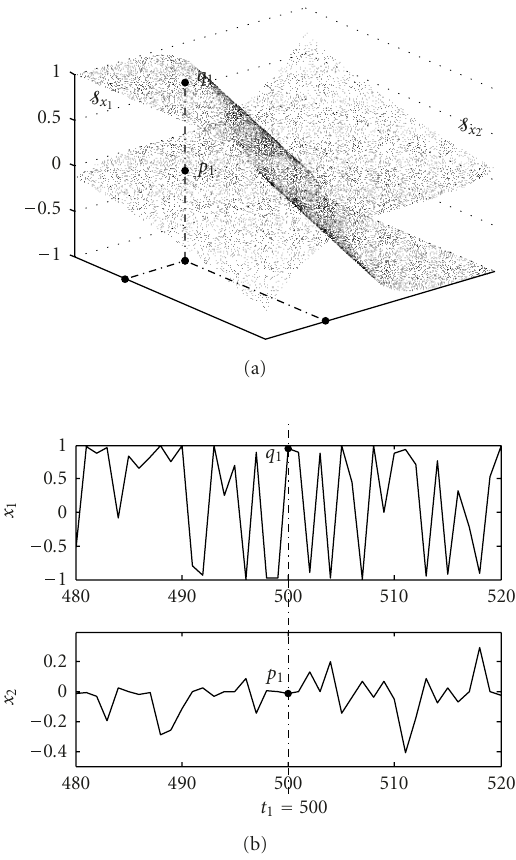
Figure 6: An illustrative example of linearizing S x using reference plane S v . (a) The point q x ∈ S x before transformation. (b) After the transformation, q x was pulled to q c ∈ q 1 q 2 .